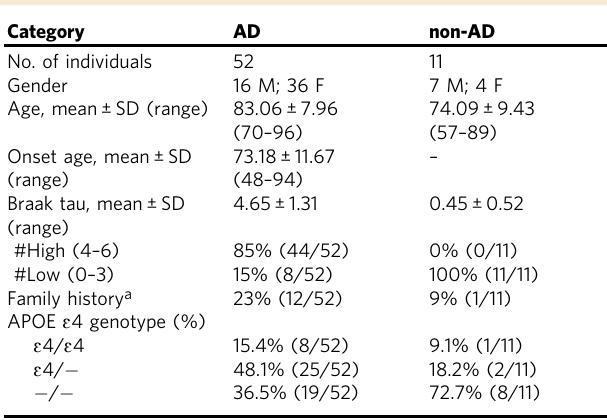
Table 1 Summary of baseline characteristics of